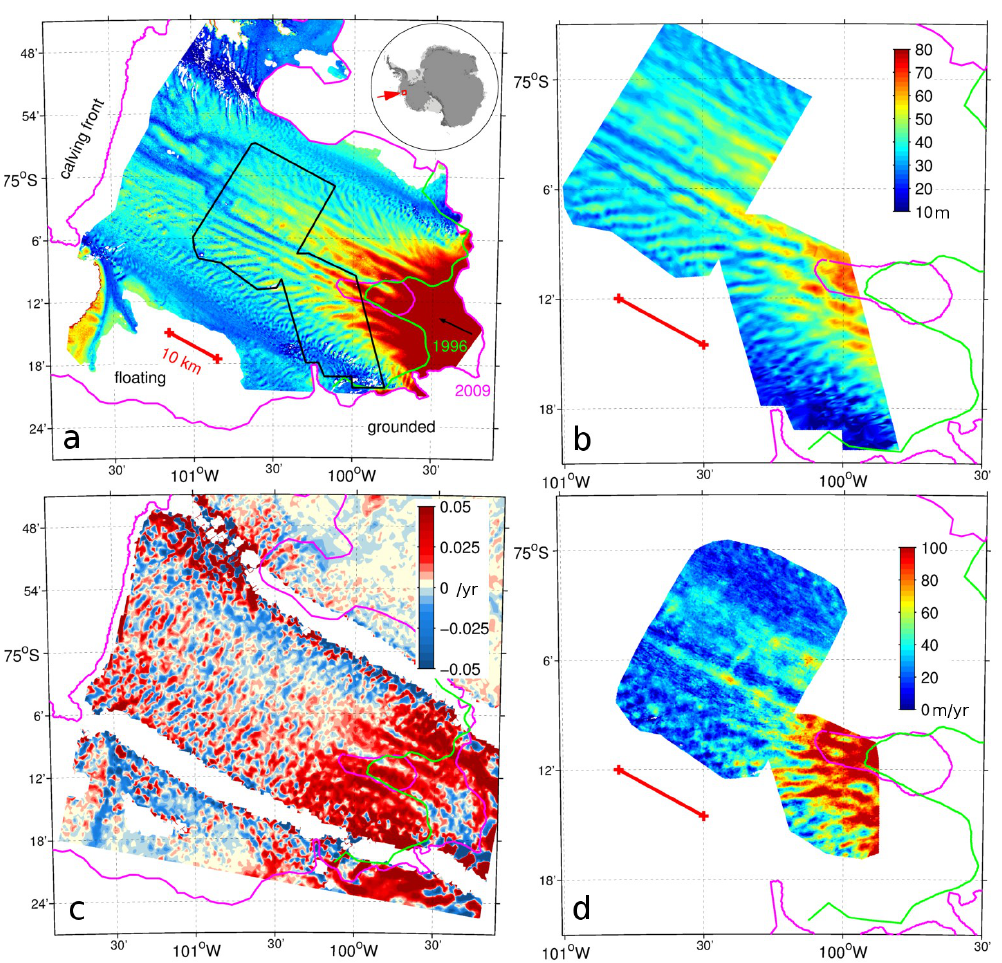
Fig. 1. (a) SPIRIT DEM acquired on 5 January 2008. The magenta line indicates the boundaries of the floating ice in 2009 (Joughin et al., 2010), while the green indicates the grounding line of the fast flowing trunk in 1996 (Rignot, 2008). The black box delineates the area covered by the airborne radar survey in (b) . The black vector indicates the ice flow direction. Inset shows the location of Pine Island Glacier in West Antarctica. (b) Surface elevation from the January 2011 radar survey linearly interpolated on the SPIRIT grid. Color bar applies to (a) and (b) . (c) November 2008 surface velocity divergence derived from a pair of InSAR data from the ALOS satellite. (d) Basal melt from Eq. (3) and using datasets in (a) , (b) and (c).